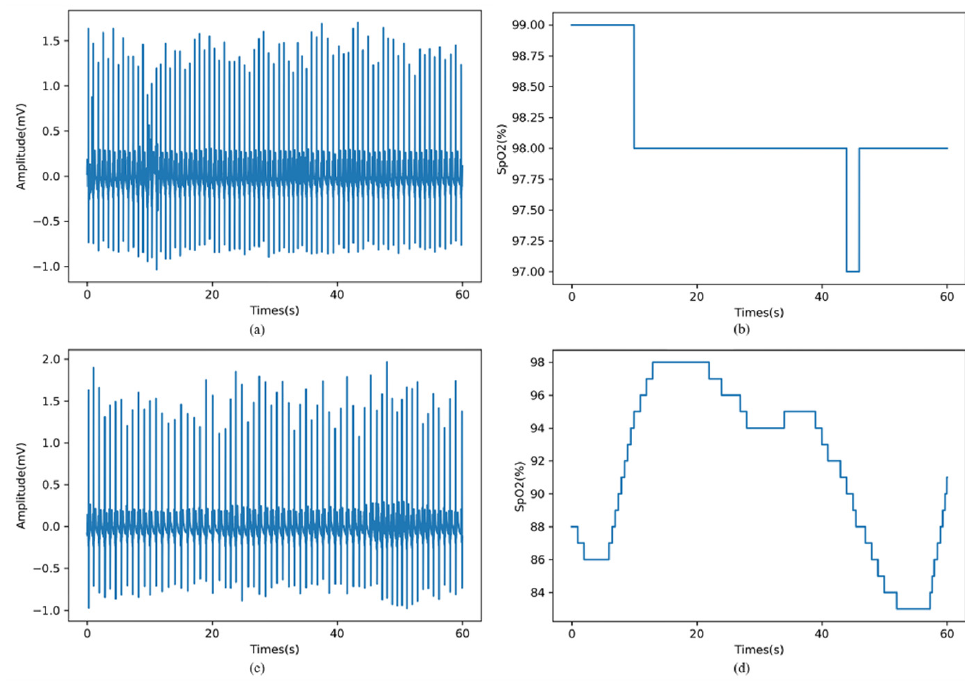
Figure 2. An example of 1-min apnea and normal segments [23]. ( a , b ) are normal ECG and SpO2 segments; ( c , d ) are apneic ECG and SpO2 segments.